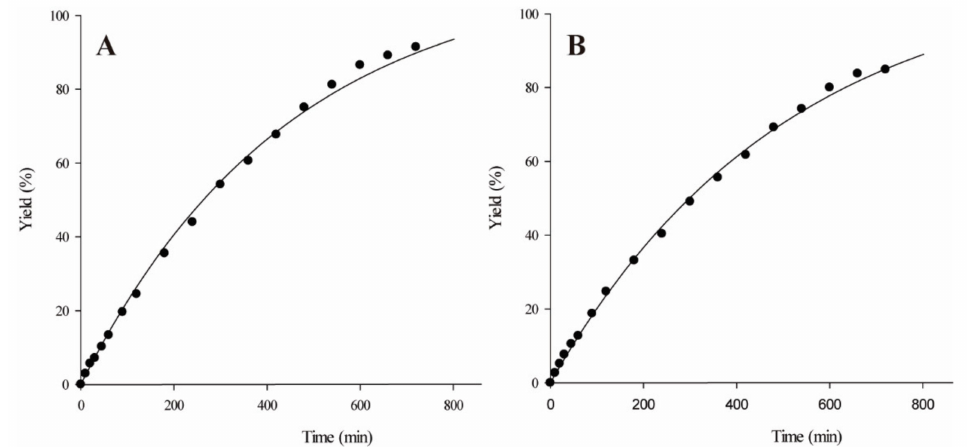
Figure 4. Isoamyl butyrate esterification yield profile with butyric acid and commercial isoamyl alcohol ( A ) or isoamyl alcohol contained in fusel oil ( B ) as substrate. The solid line corresponds to the quadratic fitting of the experimental data.